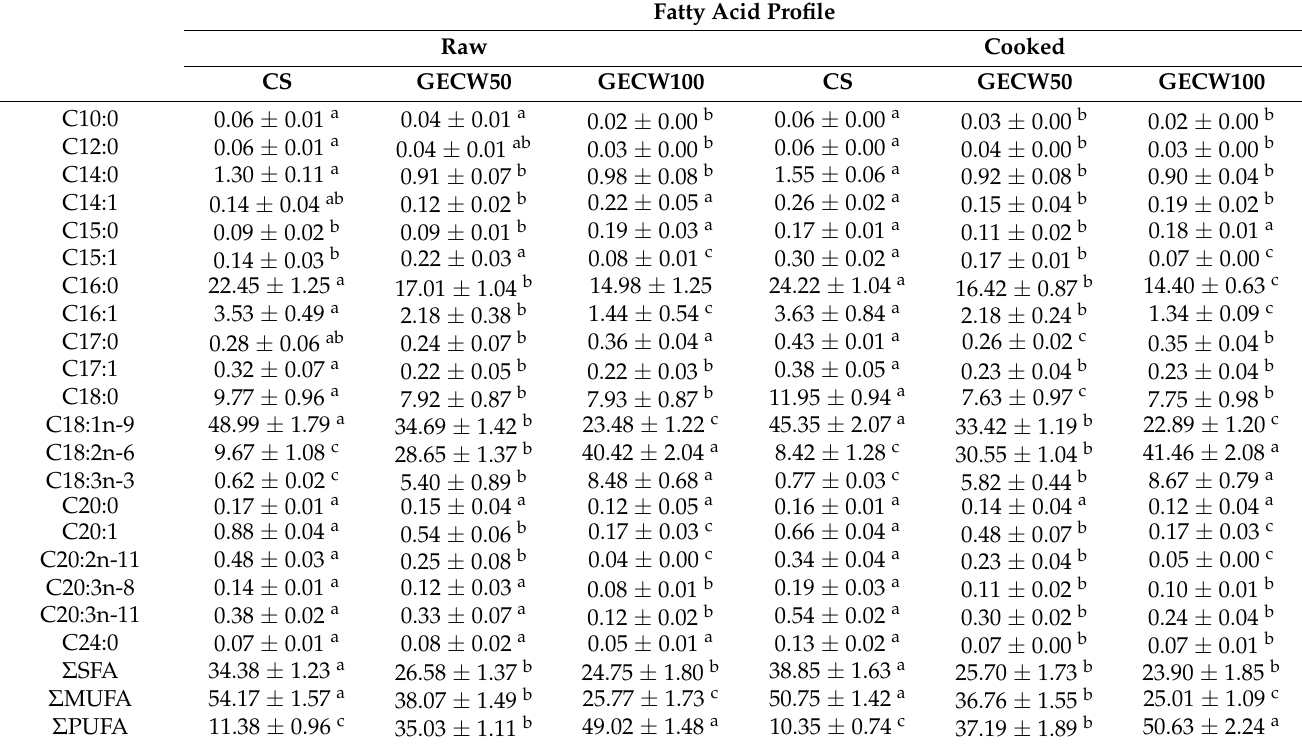
Table 3. Fatty acid profile of raw and cooked beef burger elaborated with cocoa bean shell flour and walnut oil emulsion gel as partial and total pork backfat